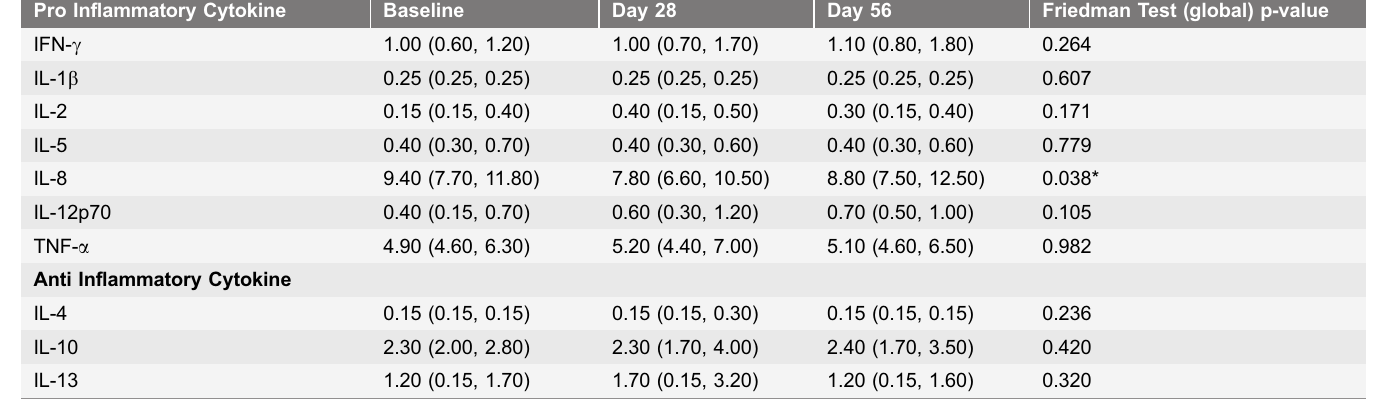
Table 6. Median and interquartile range of cytokine production